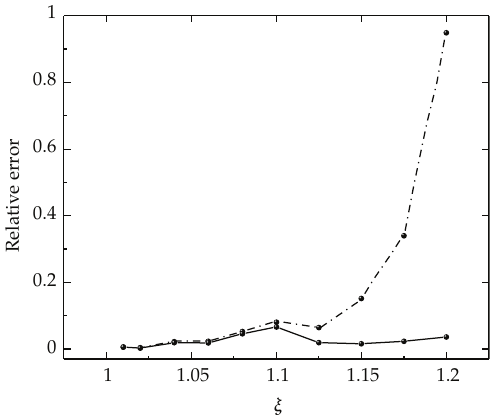
Figure 6: The relative error for the frequency ω (cid:3) α (cid:9) 1, θ (cid:9) 0 . 999939, h (cid:9) − 2 . 3 (cid:4) . Dash-dotted line with symbols: relative error between 2nd-order HAM approximation and numerical results; solid line with symbols: relative error between 5th-order HAM approximation and numerical